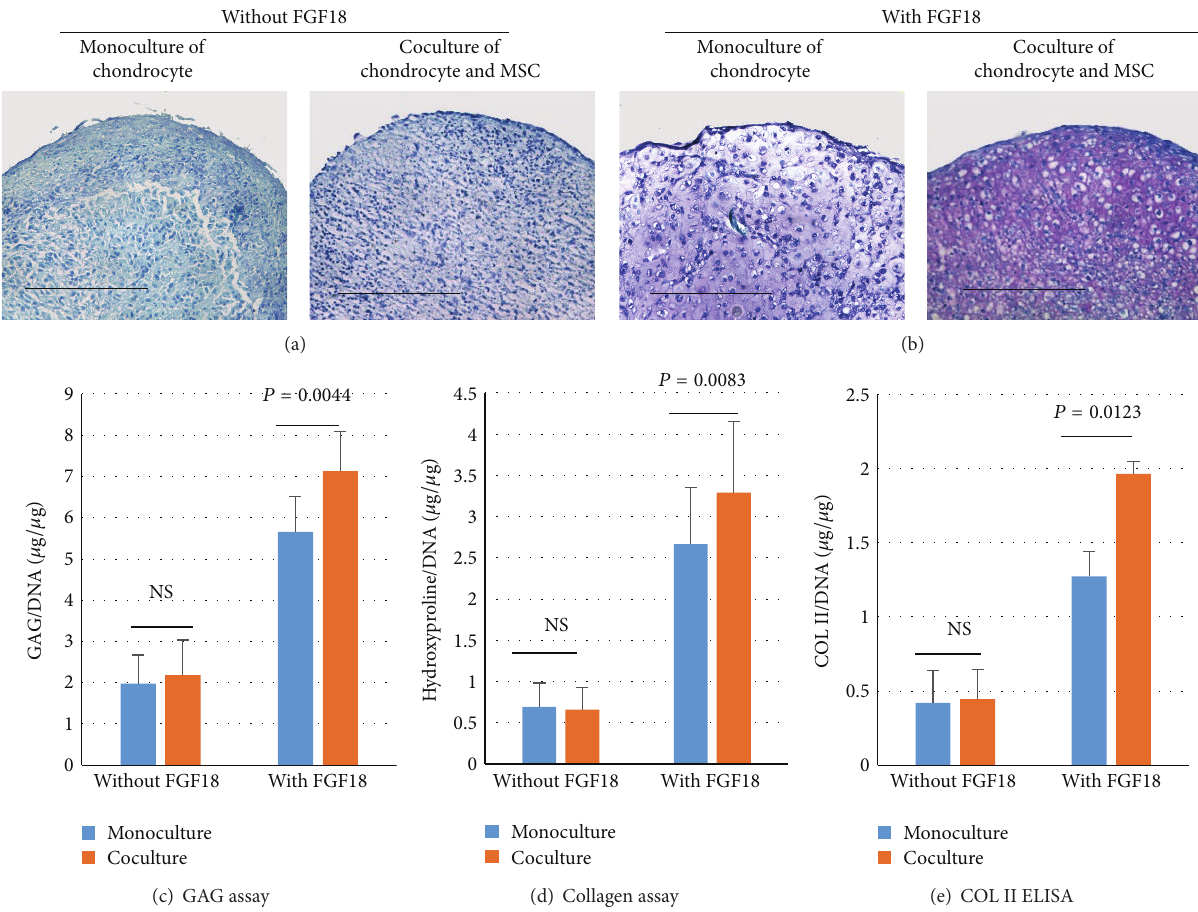
Figure 1: Coculture of MSCs and OA chondrocytes increases GAG formation and collagen biosynthesis with the presence of FGF18. (a) Toluidine blue staining was performed at week 4 after aggregation that was cultured in medium without FGF18 to detect GAGs. Scale bar = 100 𝜇 m. (b) Toluidine blue staining was performed at week 4 after aggregation that was cultured in medium containing FGF18 to detect GAGs. Scale bar = 100 𝜇 m. (c) GAG assay was performed to quantify GAG deposited in cell pellets ( 𝑛 = 3 ) at week 4 after aggregation. Total GAGs ( 𝜇 g) were normalized to total DNA ( 𝜇 g). Error bar reflects standard deviation. 𝑃 values were calculated with Student’s 𝑡 -test. (d) Hydroxyproline assay was carried out to measure total collagen contents ( 𝑛 = 3 ). Total collagen ( 𝜇 g) was normalized to total DNA ( 𝜇 g). Error bar reflects standard deviation. 𝑃 values were calculated with Student’s 𝑡 -test. (e) Deposition of COL II in pellets was measured by ELISA ( 𝑛 = 3 ). COL II contents were normalized to total DNA. 𝑃 values were calculated with Student’s 𝑡